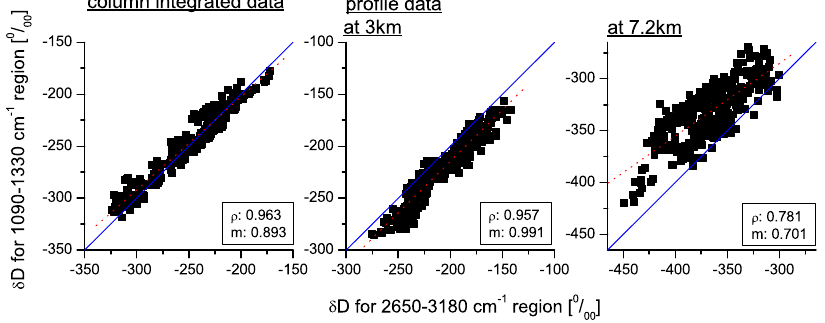
Fig. 16. Same as top panels of Fig. 13 but for δ D profile retrievals and for column integrated, lower, and middle/upper tropospheric δ D ( 3 and 7 . 2 km, respectively).